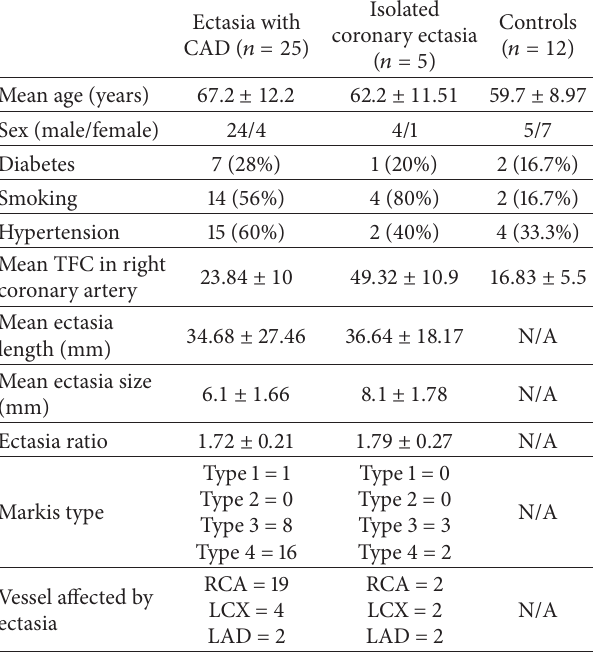
Table 1: Clinical characteristics of patients with coronary ectasia and control subjects with normal coronary